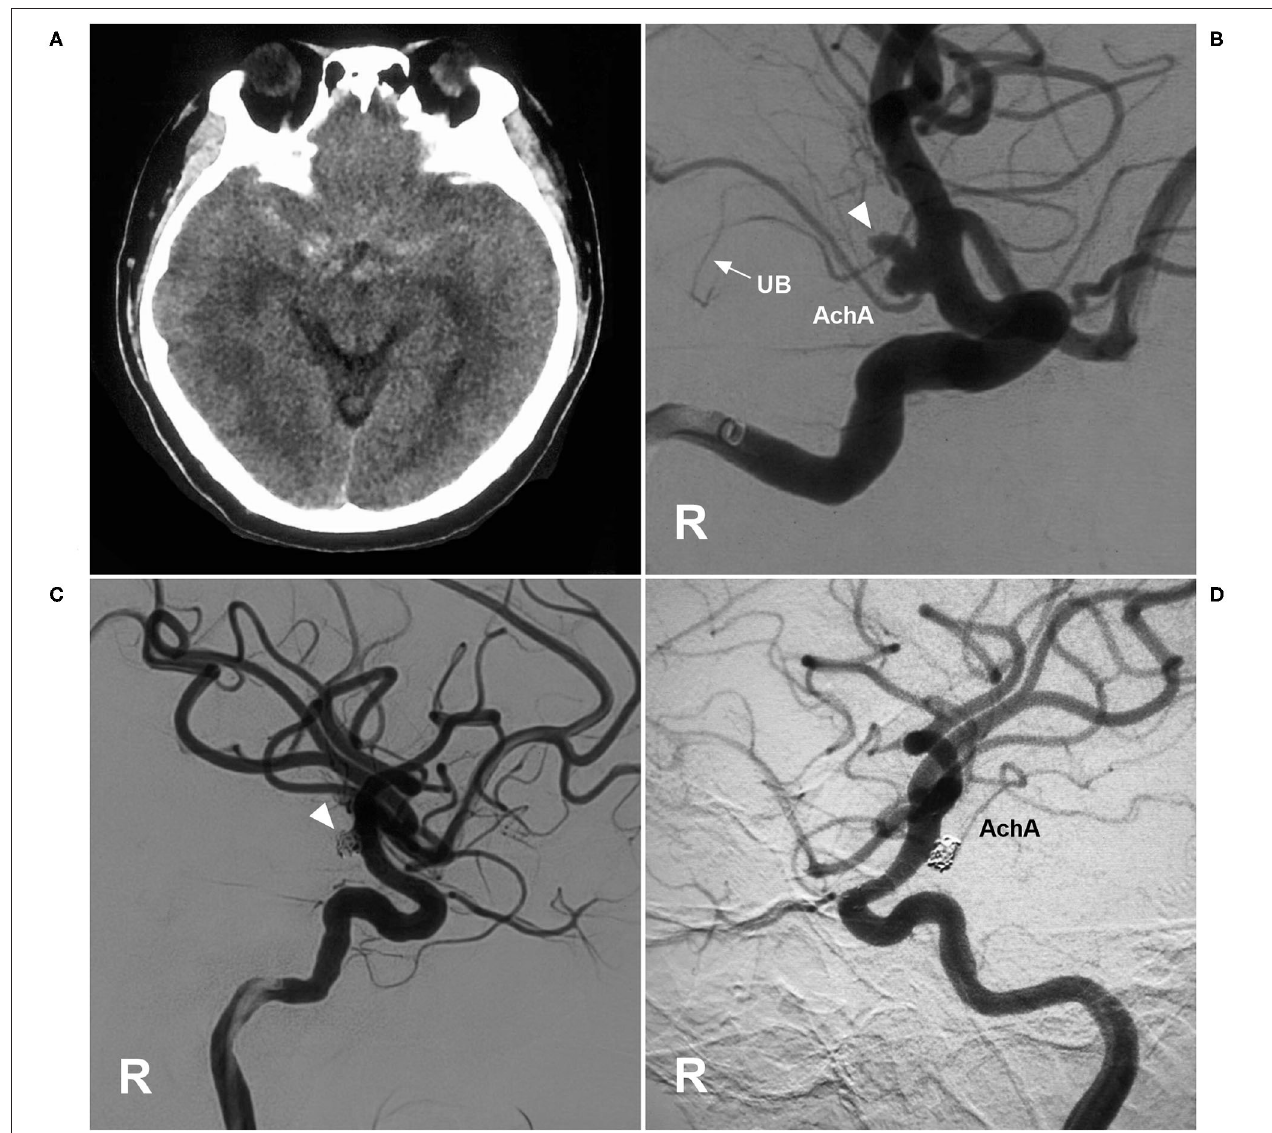
FIGURE 7 | EVT of an AchA aneurysm with AchA occlusion. (A) CT showing subarachnoid hemorrhage. (B) DSA of the right ICA showing a type II AchA aneurysm (triangle). The AchA was hyperplastic, and the uncal branch (UB, arrow) could be seen. (C) DSA of the right ICA showing that the aneurysm was coiled (triangle); however, the AchA was occluded, without new neurological deficits. (D) Follow-up DSA showing the aneurysm with embolization with MRCC grade I, and the AchA reappeared. AchA, anterior choroidal artery; CT, computed tomography; DSA, digital subtraction angiography; EVT, endovascular treatment; ICA, internal